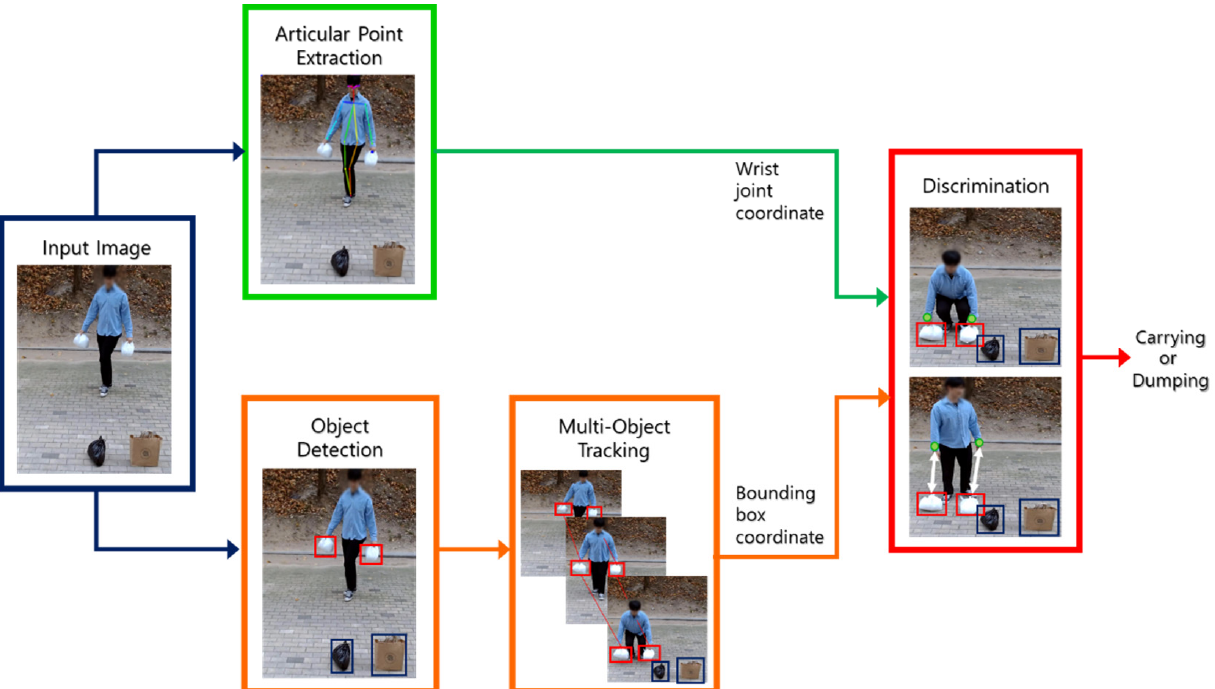
Figure 2. Schematic diagram of the proposed monitoring system for illegal dumping.